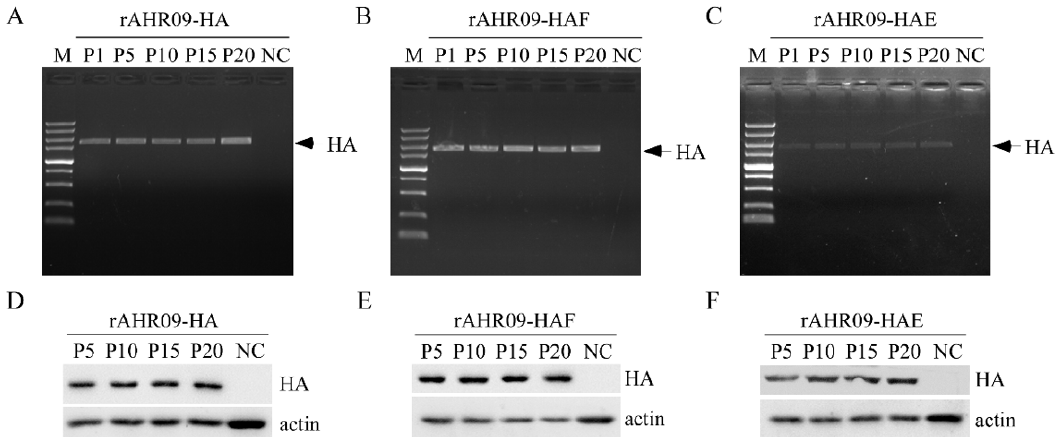
Figure 3. The recombinant NDVs were stable upon 20 passages in embryonated chicken eggs. The three plasmids prAHR09-